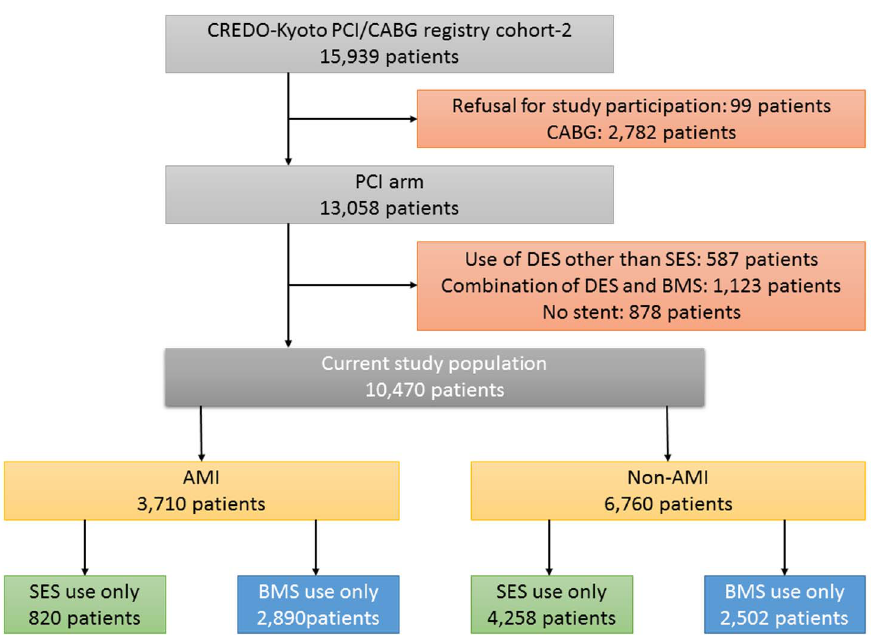
Figure 1. Study flow chart of patients with drug-eluting stent thrombosis who underwent thrombus aspiration with retrieved material sufficient for the histopathologic analysis. DES 5 drug-eluting stents, EST 5 early stent thrombosis, LST 5 late stent thrombosis, and VLST 5 very late stent thrombosis.